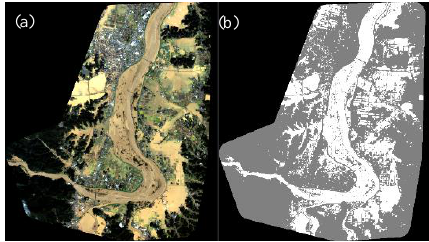
Figure 9. Post disaster image (a) and annotation image (b)